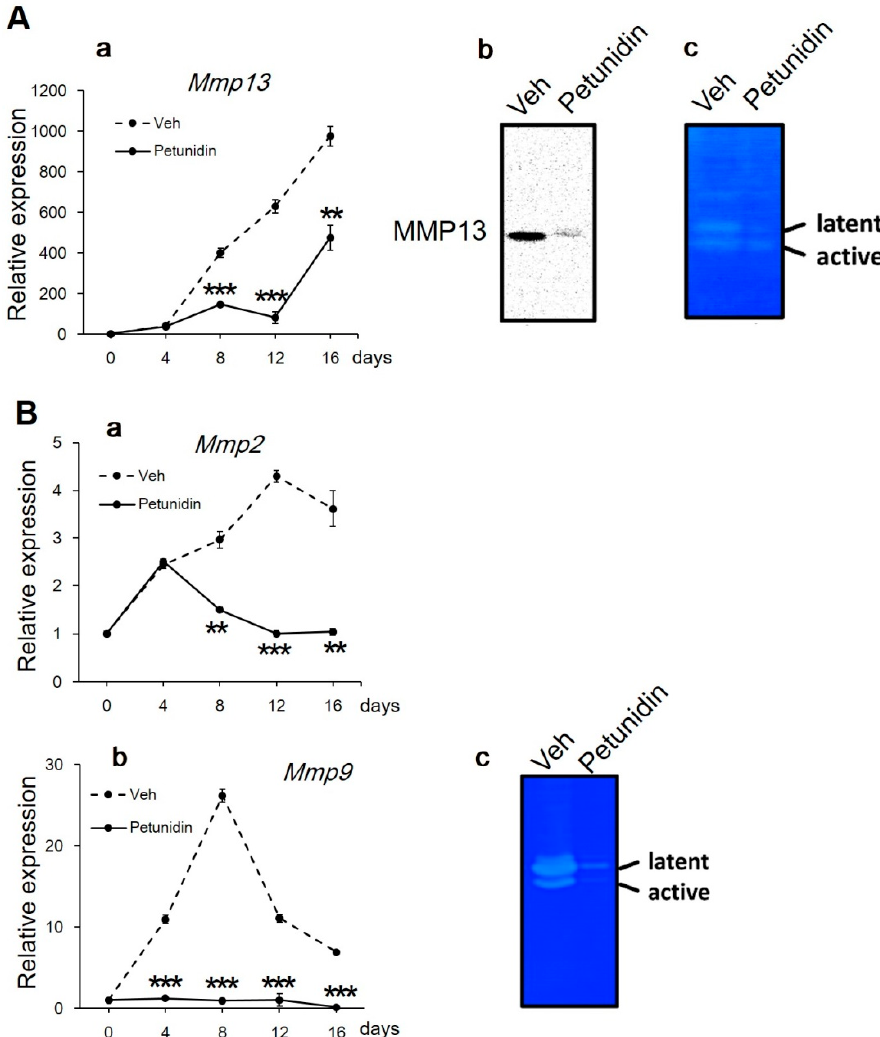
Figure 5. E ff ects of petunidin on ECM degradation. ( A ) Expression level of Mmp13 mRNA (Figure 5Aa) was analyzed by qPCR. Expression of MMP13 protein was analyzed by western blotting (Figure 5Ab). In gel zymography was performed using the concentrated conditioned media harvested on day 16 in MC3T3-E1 cells cultured with or without 32 µ g / mL petunidin. Samples were electrophoresed in 7.5% SDS-polyacrylamide gel containing 0.1% casein as a substrate, then stained with Coomassie Brilliant Blue R-250 after overnight incubation to detect a matrix-degrading activity (Figure 5Ac latent form and active form correspond to ~60 and ~48 kDa, respectively). ( B ) Expression levels of Mmp2 and Mmp9 mRNA (Figure 5Ba,b, respectively) were analyzed by qPCR. In gel zymography was performed in 7.5% SDS-polyacrylamide gel containing 0.1% gelatin as a substrate (Figure 5Bc, latent form and active form correspond to ~103 and ~86 kDa, respectively). Data in Figure 5Aa,Ba,Bb are expressed as mean ± SEM ( n = 4). ** p < 0.01, *** p < 0.001.